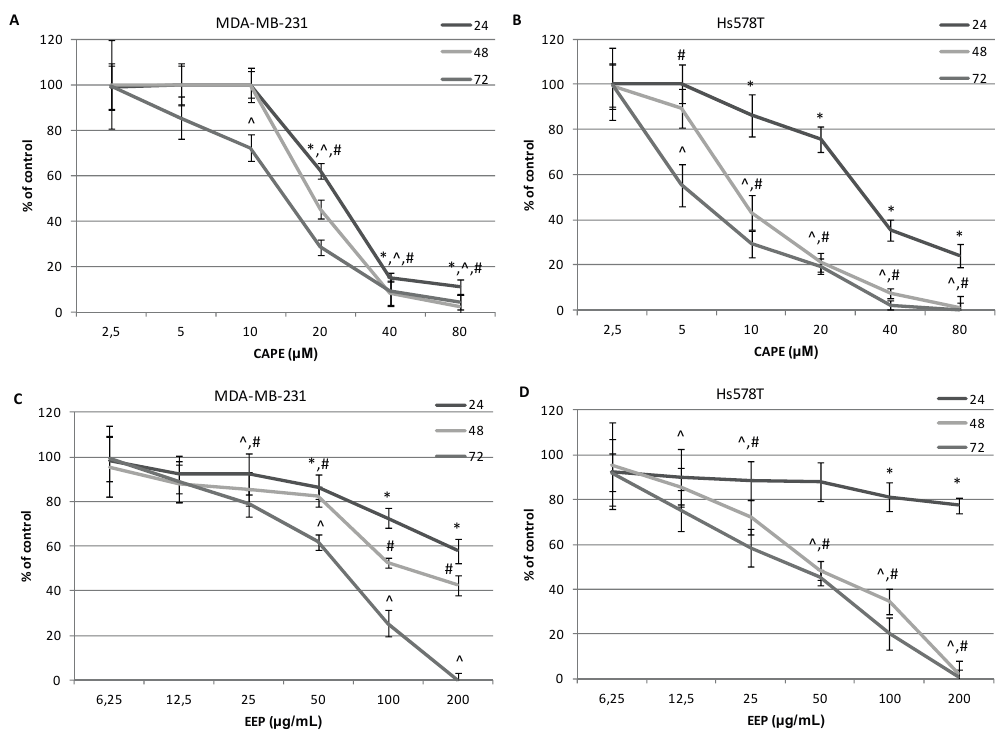
Figure 4. Effect of CAPE and EEP on the viability of MDA-MB-231 and Hs578T cells. The cytotoxicity was evaluated by the LDH assay after 24, 48 and 72 h of incubation of cells with 6.25–200.0 μ g·mL − 1 EEP or with 2.5–80.0 μ M CAPE. The values represent the mean ± SD of three independent experiments ( n = 12). ( A ) Cytotoxic activity of CAPE against MDA-MB-231 cells. ( B ) Cytotoxic activity of CAPE against Hs578T cells. ( C ) Cytotoxic activity of EEP against MDA-MB-231 cells. ( D ) Cytotoxic activity of EEP against Hs578T cells. The percentage of cell death was measured using the LDH cytotoxicity assay. Results are presented as the means of cytotoxicity ± SD. *, ^ , # indicate statistically-significant differences compared to the control: * after 24 h incubation, # after 48 h and ^ after 72